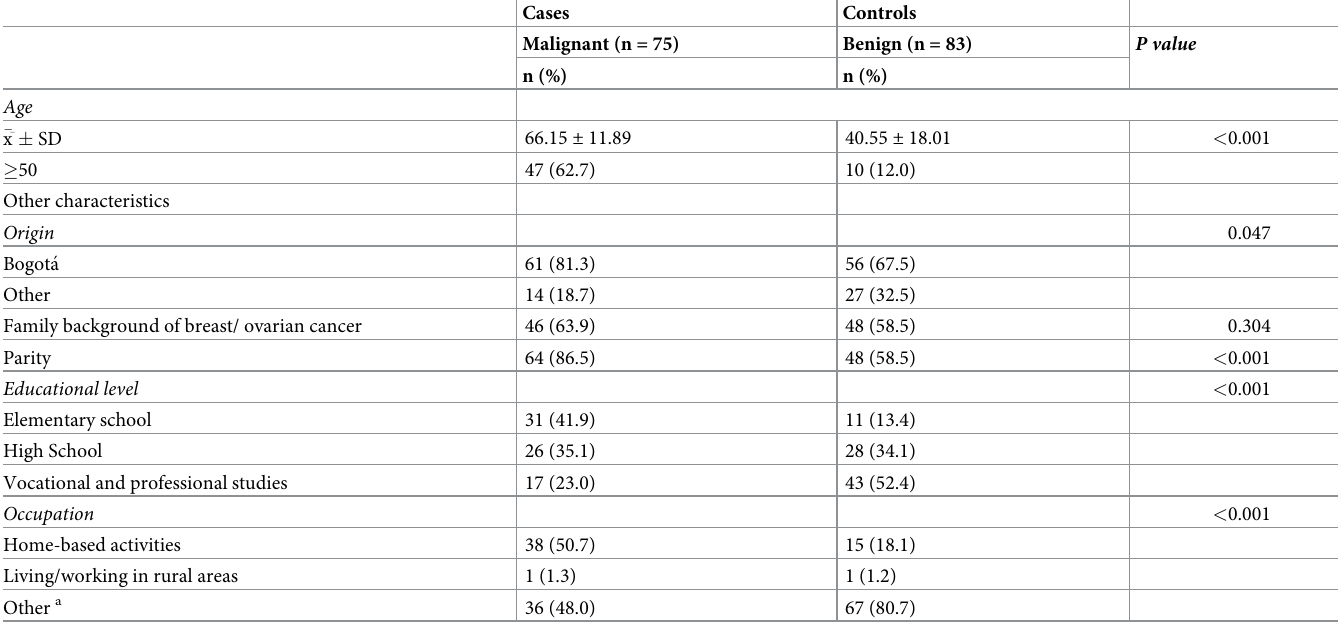
Table 1. Comparison of sociodemographic and biological characteristics between malignant (cases) and benign samples (controls).